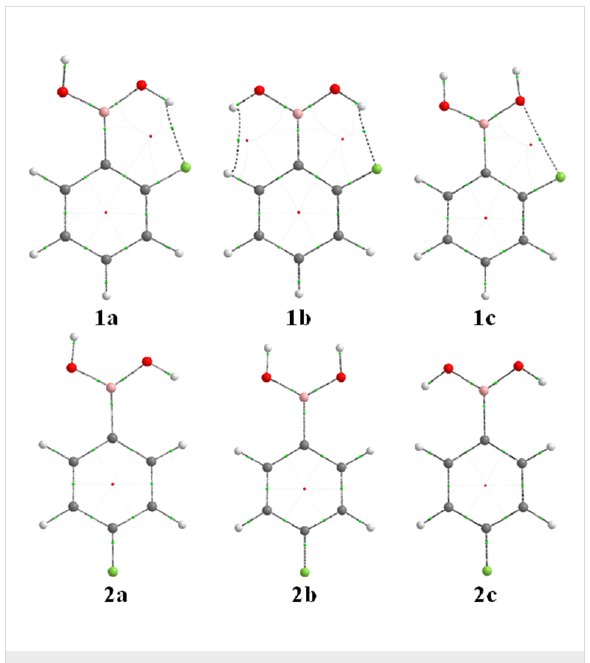
Figure 2: Molecular graphs for the energy minima of 2- and 4-fluoro- phenylboronic acids. Green dots represent bond critical points and red dots represent ring critical